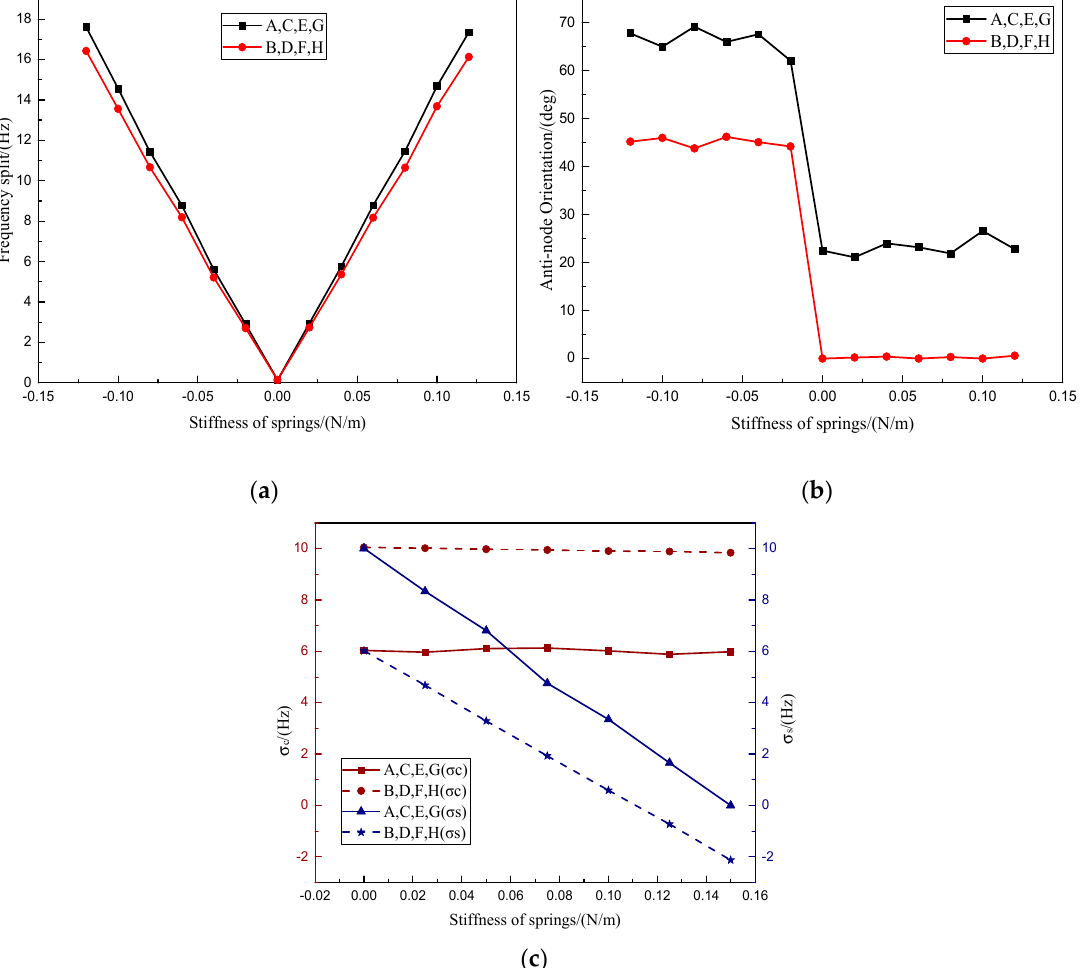
Figure 5. ( a ) Frequency split as function of the equivalent stiffness on corresponding electrodes ( b )